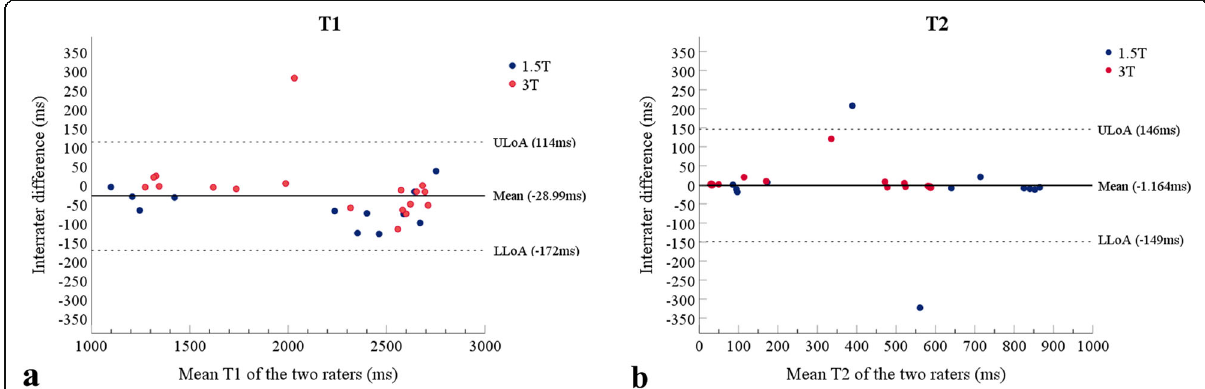
Fig. 4 Bland-Altman plots for interobserver agreement regarding T1 and T2 measurements at 1.5 and 3 T. Horizontal dashed lines indicate the upper and lower limit of agreement from the mean by the two observers (ULoA/LLoA). For T1 measurements, the mean was − 28.99ms, with a limit of agreement (LoA) equal to 143 ms. For T2 measurements, the mean was − 1.164 ms with LoA equal to 148 ms